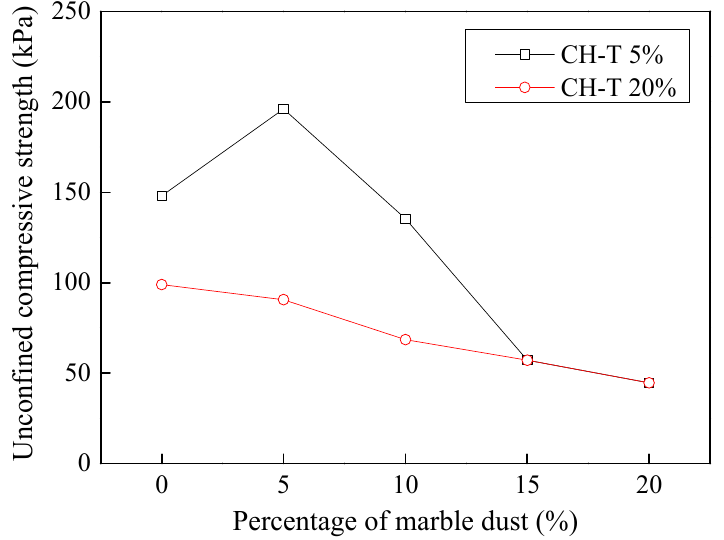
Figure 25. Improvement in tannery effluent contaminated CH soil using marble dust.